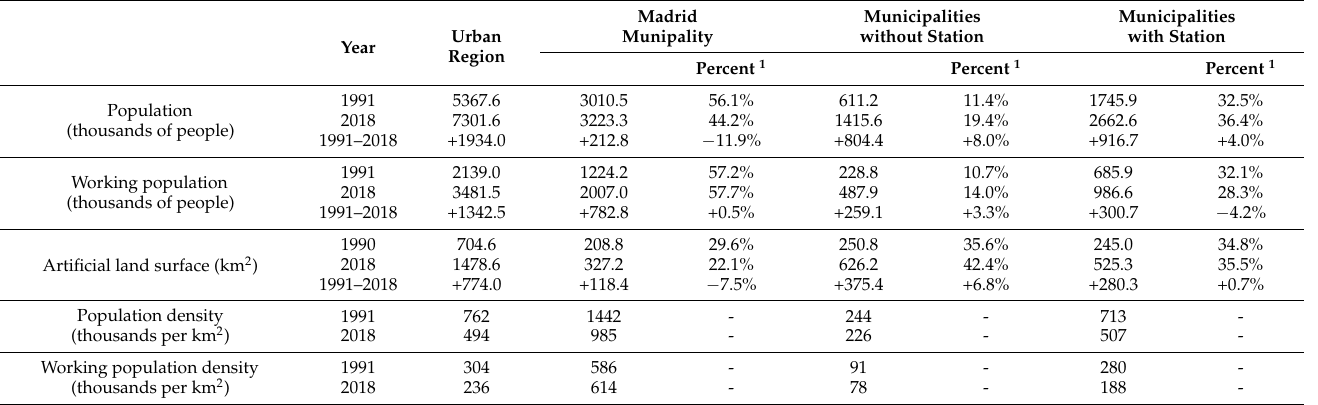
Table 5. Evolution of the population, the working population and the artificial land area, distinguish- ing municipalities with and without a commuter station, between 1991 and 2018. Source: 1991 and 2018 Population Census (INE), Workers Affiliated to Social Security (Ministry of Inclusion, Social Security and Migrations) and CORINE Land Cover (National Geographic Information Centre).